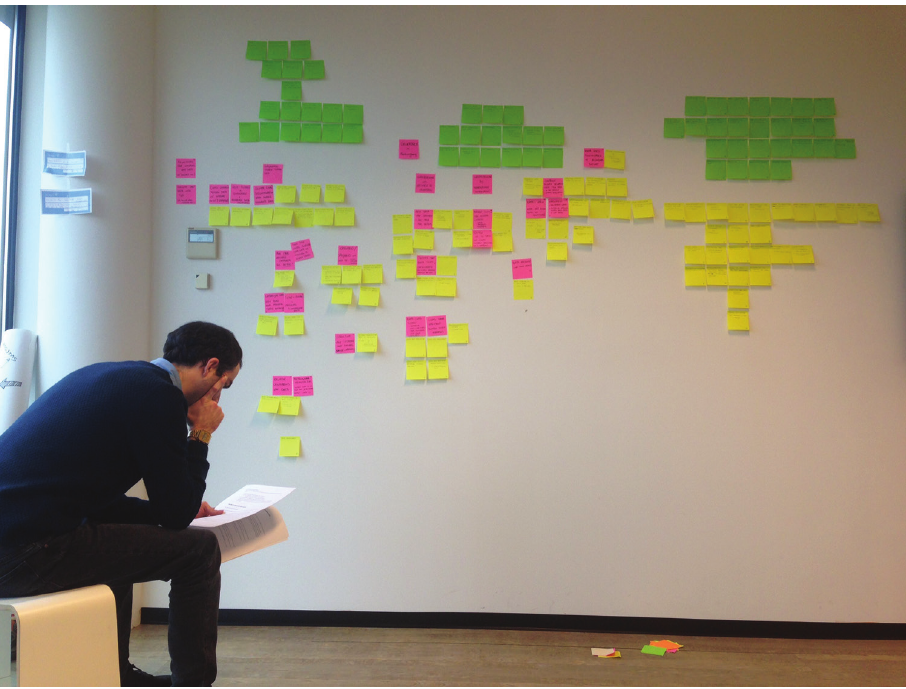
Figure 2. A user experience researcher using affinity diagramming to cluster user requirements from the results of the